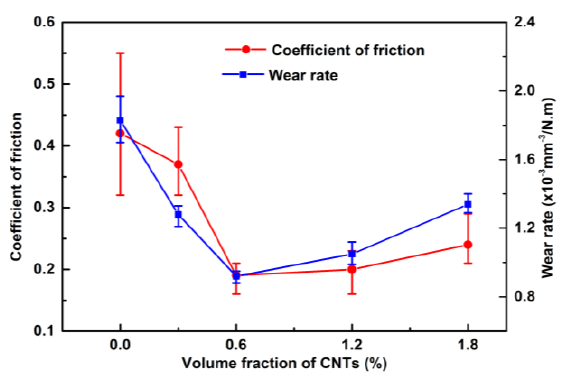
Figure 7. Coe ffi cient of friction (COF) and wear rates of pure Cu and Cu / CNT composites with a Figure 7. Coefficient of friction (COF) and wear rates of pure Cu and Cu/CNT composites with a pressure of 10 N under dry sliding pressure of 10 N under dry sliding conditions.